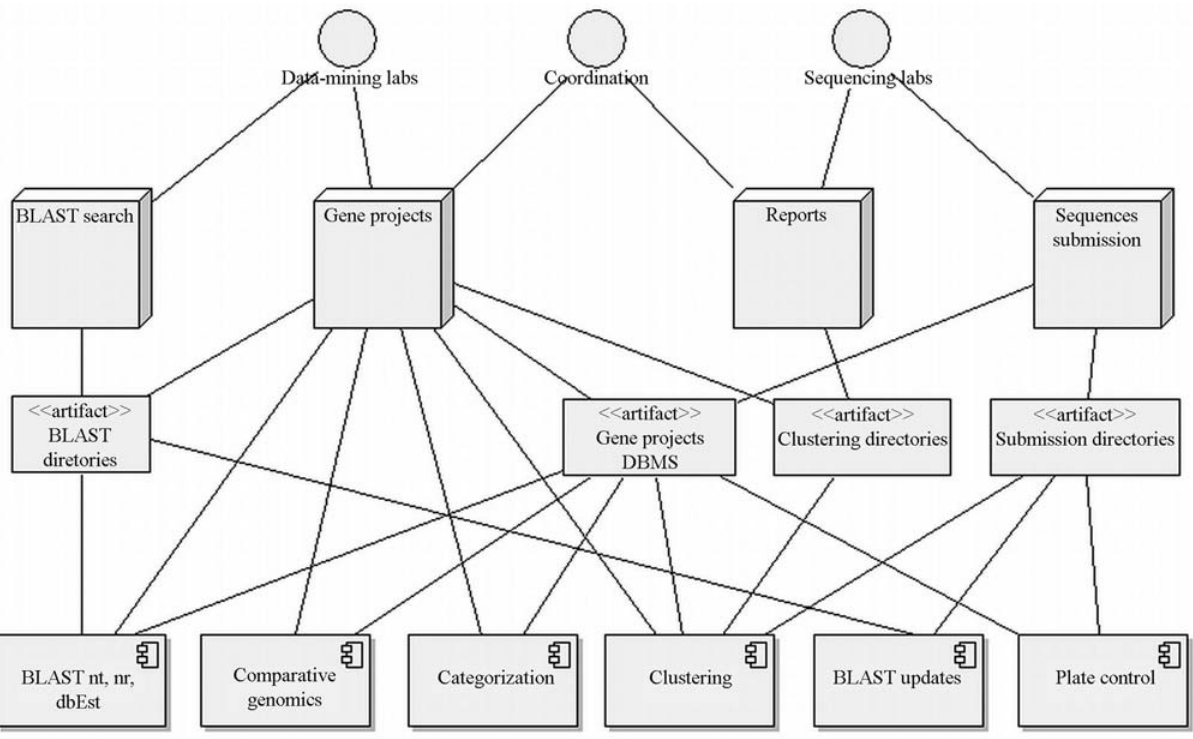
Figure 1 - Diagram of the CitEST transcriptome project systems. There are three main interfaces: one for the Data-mining Laboratories, another for the Coordination, and a third for the Sequencing